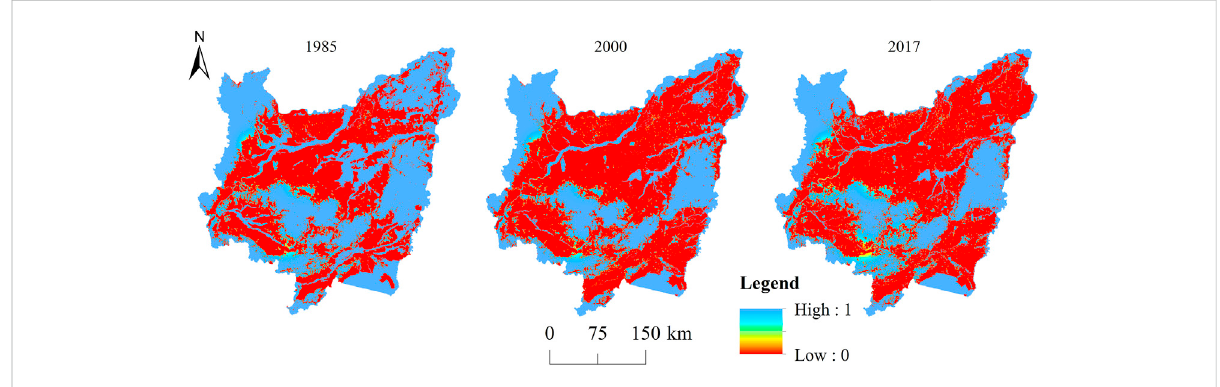
FIGURE 6 Spatial-temporal changes in habitat quality from 1985 to